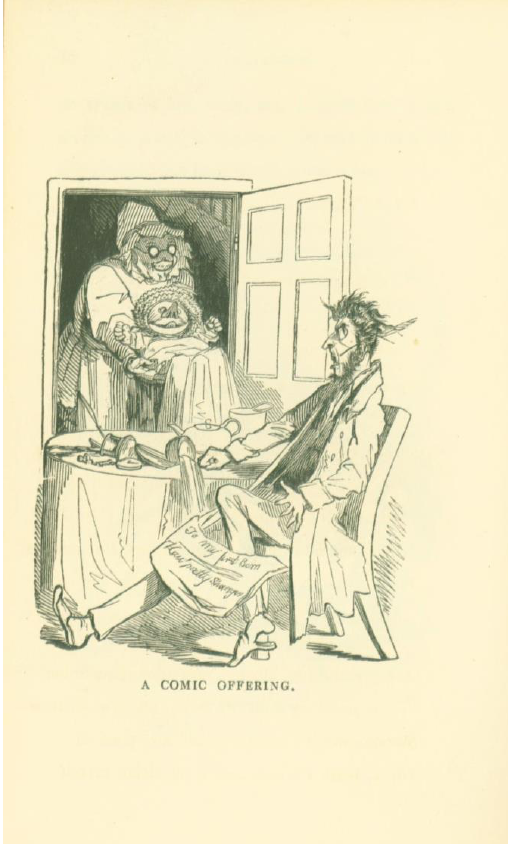
Fig. 9 A typical punning drawing by Seymour from the second volume of the Comic Magazine. Apart from the obvious humour suggested by the proud presentation of a startlingly ugly baby, ‘the comic offering’ was also an allusion to the gift book annual the Comic Offering which formed a rival publication to the Comic Magazine . The good humour of Seymour’s allusion doubtless derived from his own extensive contributions to the annual and the appearance of Henrietta Louise Sullivan, the Comic Offering ’s editor, among the contributors to the Comic Magazine